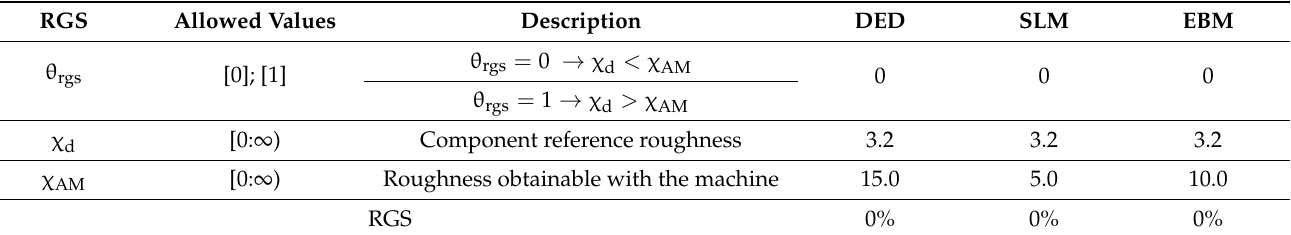
Table 6. Roughness analysis (RGS) calculation for the FDM head for traditional plastics.